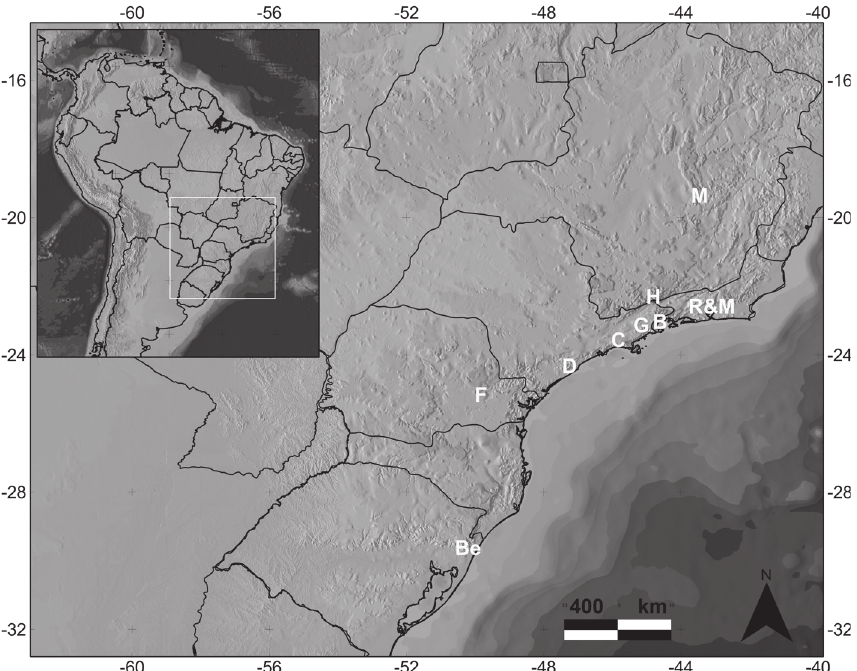
Figure 1. Locations where elevational bird surveys were conducted in Brazilian Atlantic Forests: (B) B UZZETTI (2000), (Be) B ENCKE & K INDEL (1999), (C) this study, (D) D EVELEY (2004), (G) G OERCK (1999), (H) H OLT (1928), (M) M ELO -J ÚNIOR et al. (2001), (F) F ÁVARO et al. (2006), (R&M) R AJÃO & C ERQUEIRA (2006), and M ALLET -R ODRIGUES et al. (2010). S TOTZ et al. (1996) contemplated the whole Atlantic